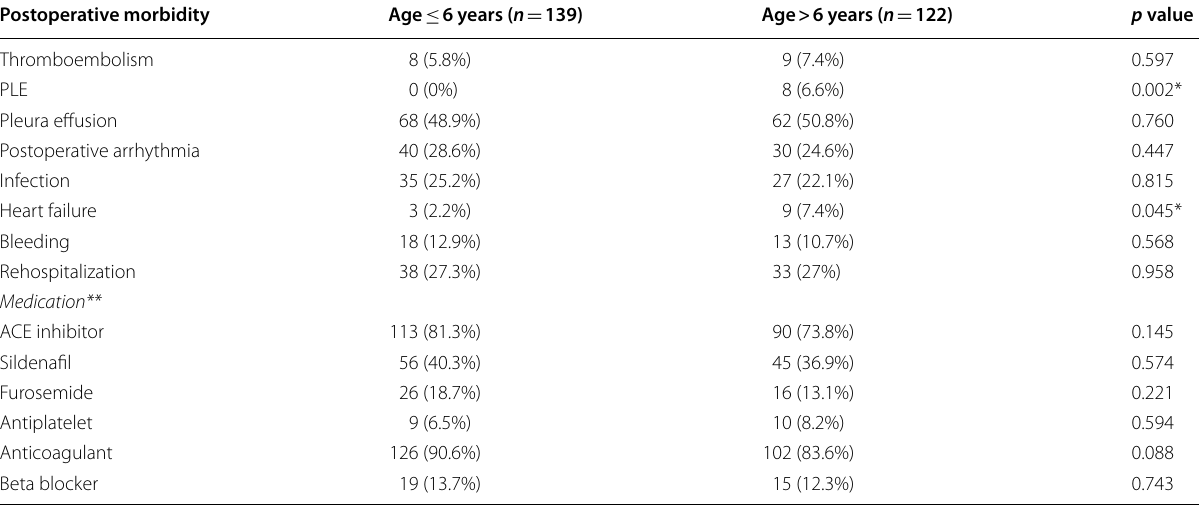
PLE protein losing enteropathy, ACE angiotensin-converting enzyme